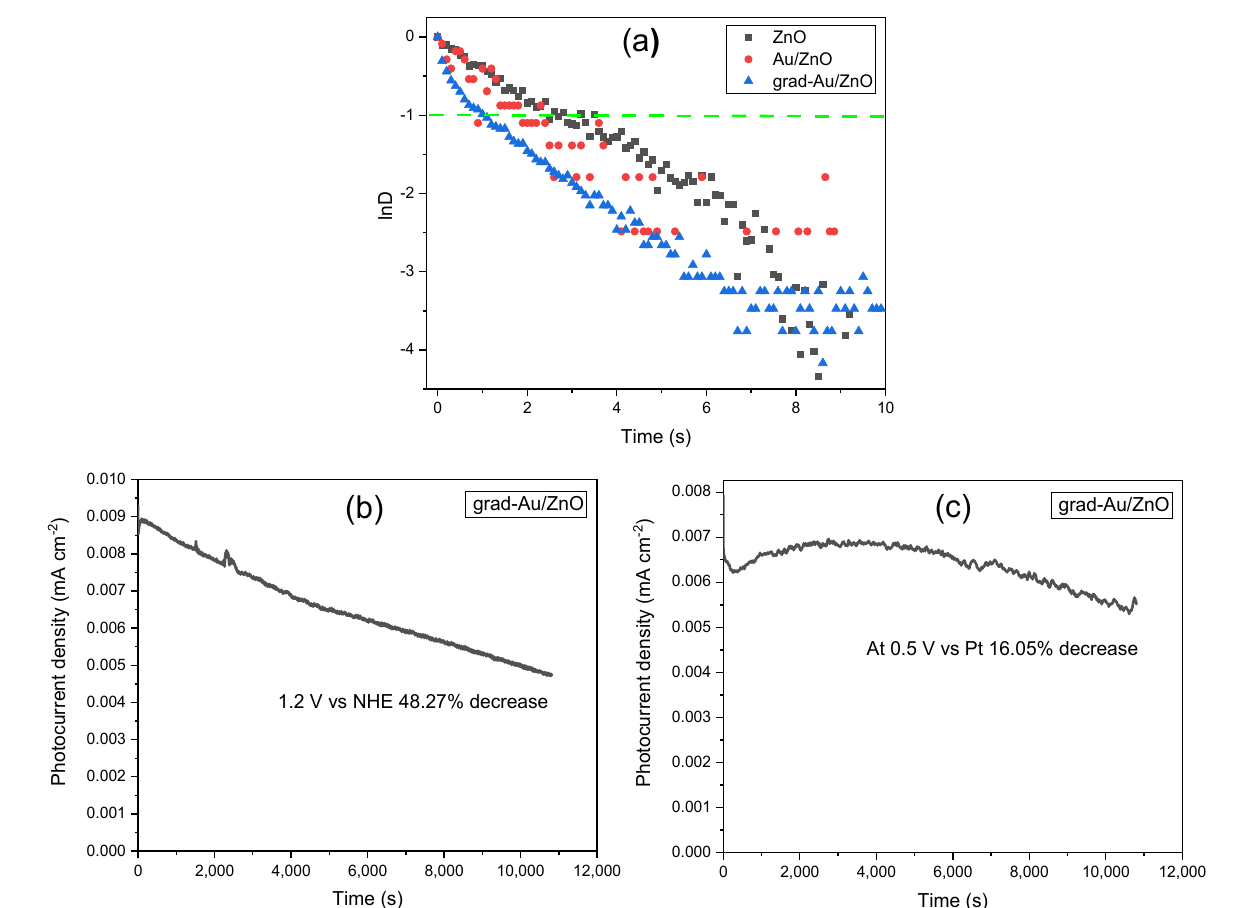
Figure 8. ( a ) Transient decay time curves of all the samples and stability tests for 3 h under illumi- nation ( b ) at an applied bias of 1.2 V vs. NHE in three electrode configuration and ( c ) at an applied bias of 0.5 V vs. Pt in two electrode configurations.